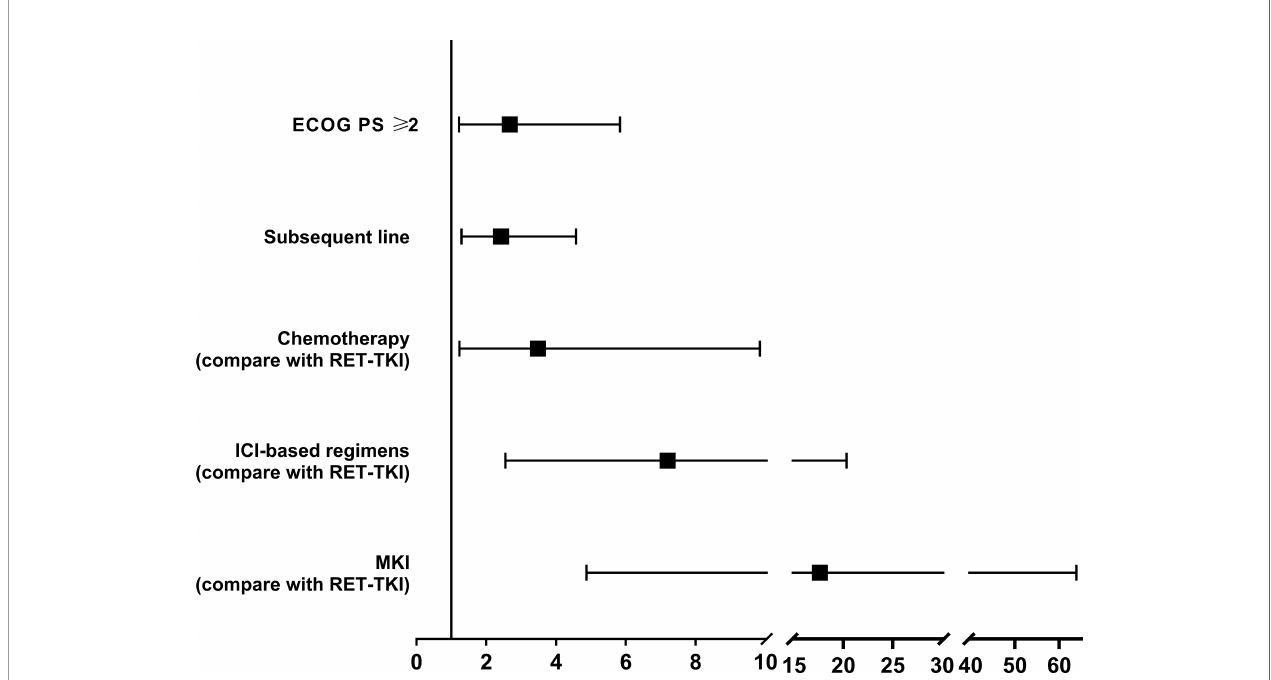
FIGURE 5 | The forest plot of the risk factors associated with the ef fi cacy of patients with RET-fusion positive non-small cell lung cancer. RET-TKI, rearranged during transfection-tyrosine kinase inhibitors. ICI, immune-checkpoint inhibitor; MKI, multi-kinase inhibitor; PD-L1, programmed death-ligand